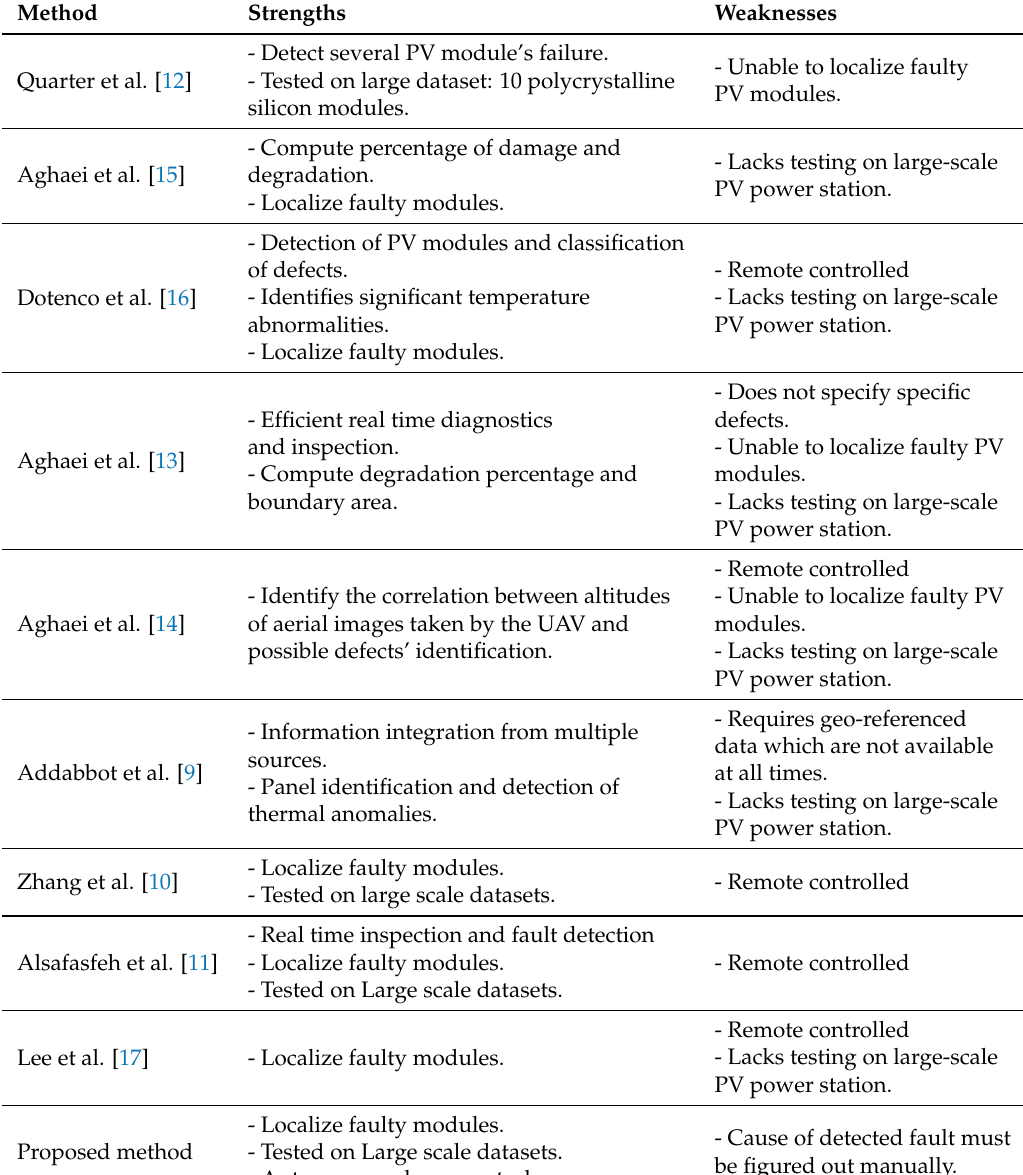
Table 1. Comparison between proposed approach and related works in terms of strengths and